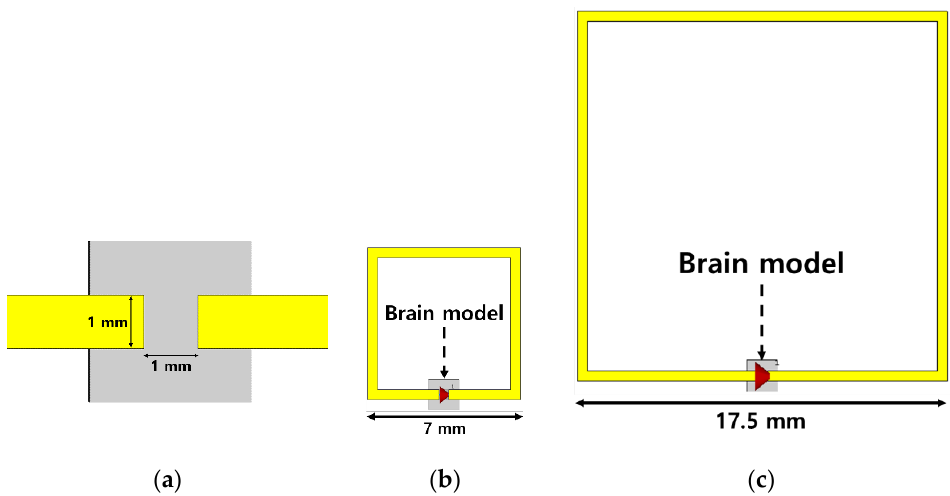
Figure 3. Top view of ( a ) the gap of SRR, ( b ) 2.4 GHz, and ( c ) 6.5 GHz SRR contacting the brain model.